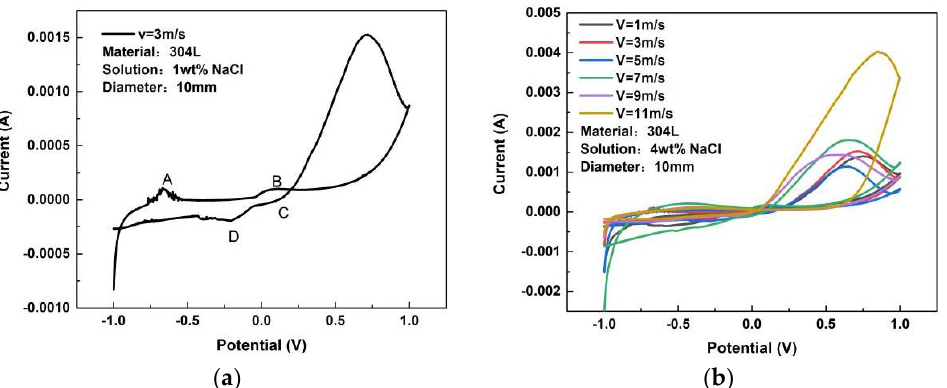
Figure 8. Cyclic voltametric curves of 304L stainless steel at different flow velocity. ( a ) Cyclic voltametric curves of 304L stainless steel at flow velocity 1 m/s; ( b ) Cyclic voltametric curves of 304L stainless steel at full flow velocity.